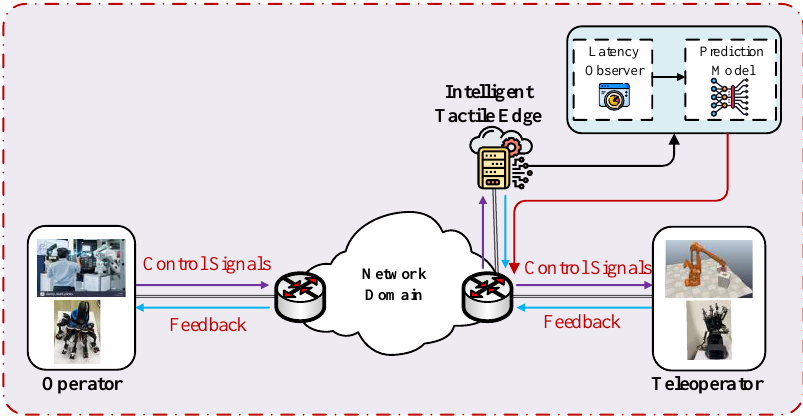
Figure 14. Conceptual architecture of ITE in